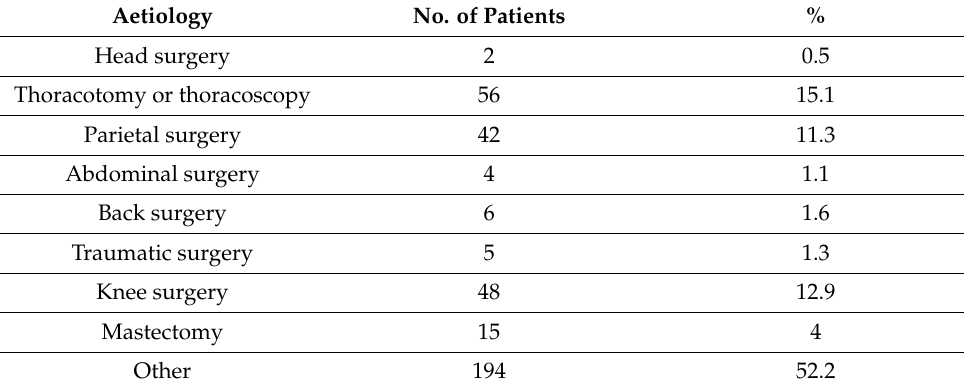
Table 3. CPSP aetiology.